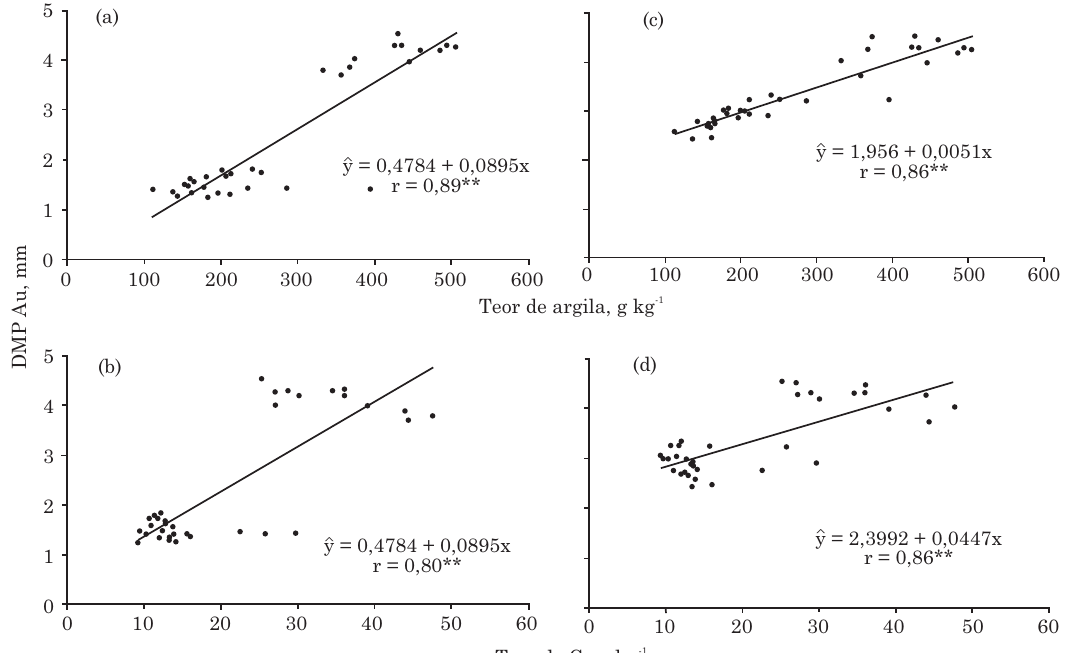
Figura 1. Correlação linear entre DMPAu e argila (a), DMPAu e carbono (b), DMPAs e argila (c) e DMPAs e carbono